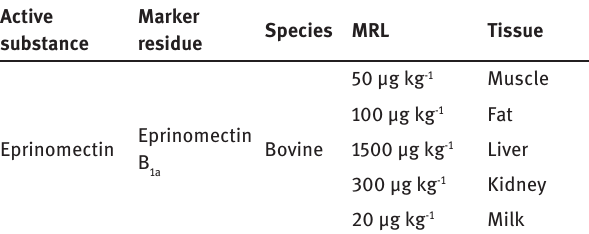
Table 1: The EMA-CVMP accepted values for MRL for bovine edible tissues and milk after EMEA/MRL/114/96 Final